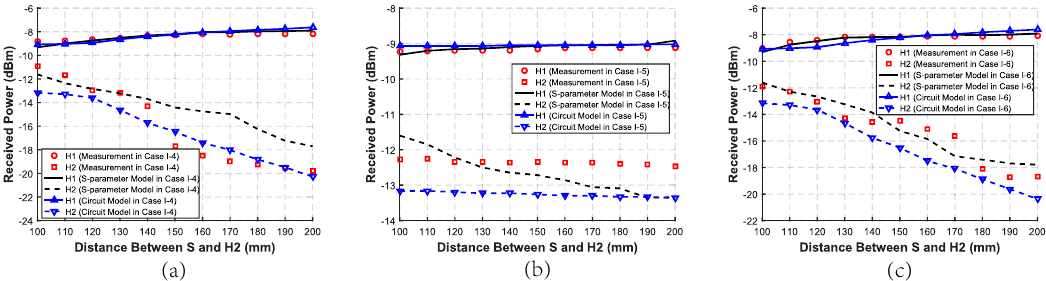
Figure 10. Measurement, simulated S-parameter model, and circuit model received power of two harvesters with different distances between S and H2 in the SSMH-SA case. ( a ) Case I-4 with only backward distance changing. ( b ) Case I-5 with only forward distance changing. ( c ) Case I-6 with forward and backward distances remaining the same.